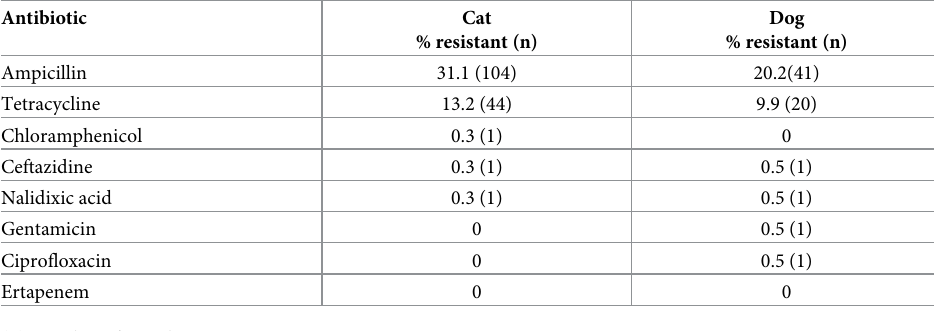
Table 4. Antibiotic disc diffusion test results for 334 E . coli isolates from cats and 203 isolates from